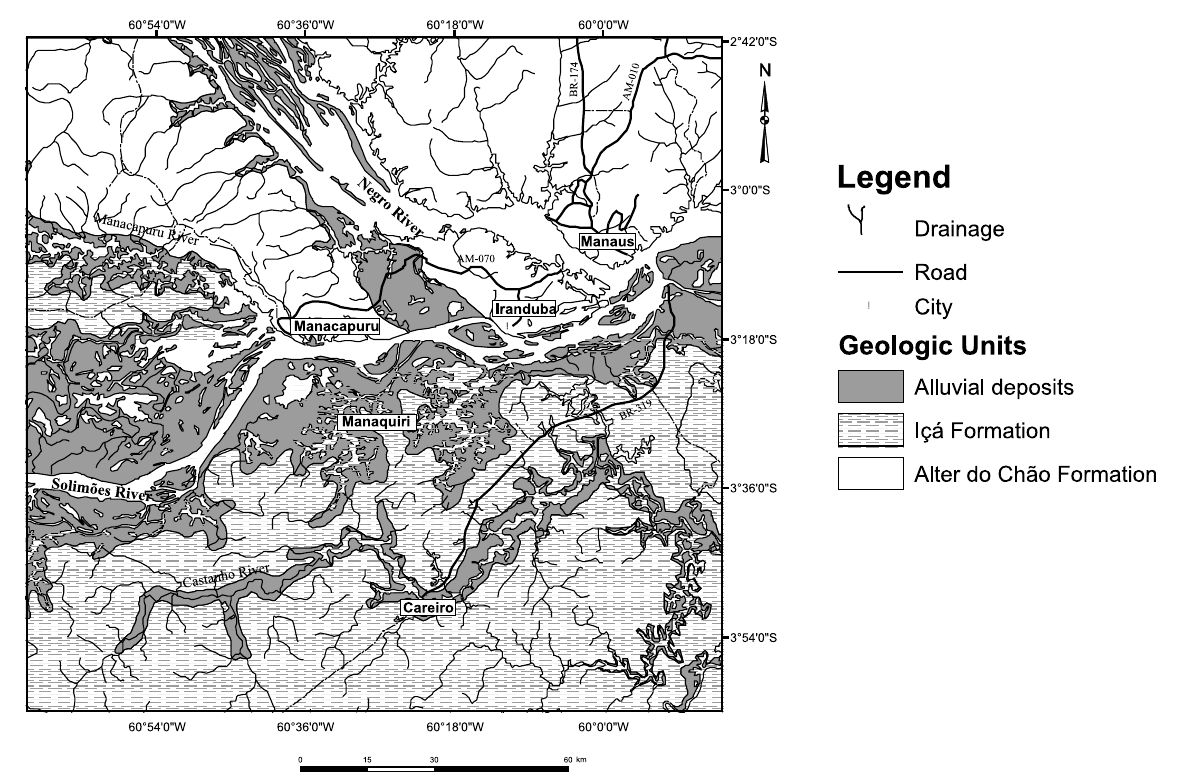
Fig. 4 – Geological map of the study region (1:2,500,000) according to Bizzi et al.